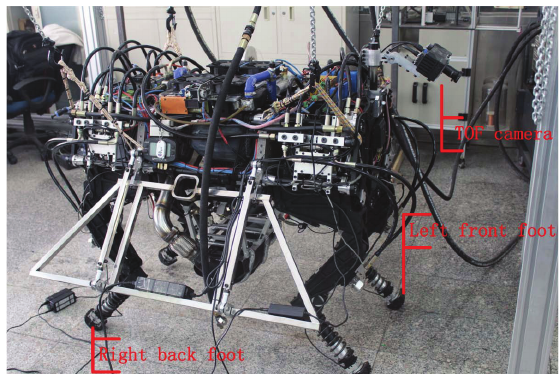
Figure 1. Physical platform of the quadruped robot.